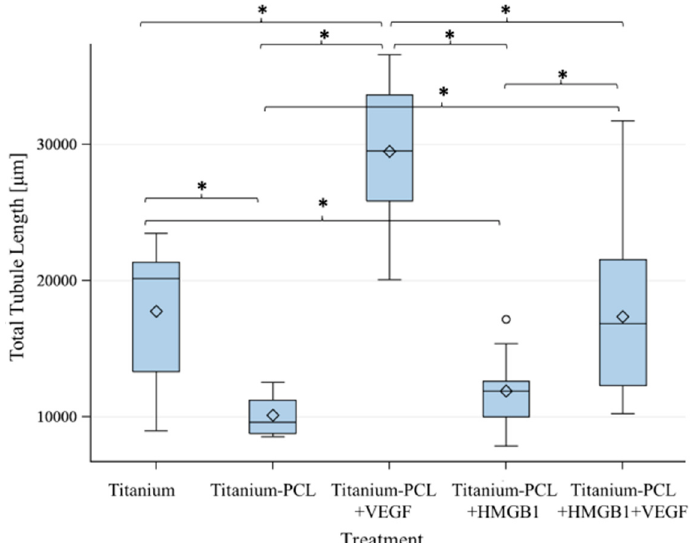
Figure 6. Total Tubule Length built by investigated implants. VEGF-functionalized titanium-PCL implants showed significantly the best results for the characteristic Total Tubule Length. VEGF + HMGB1-functionalized titanium-PCL implants showed a significantly higher Total Tubule Length than titanium-PCL implants and HMGB1-functionalized titanium-PCL implants, but comparable results to pure titanium implants. Pure titanium implants were significantly better than titanium-PCL implants and HMGB1-functionalized titanium-PCL implants. F -test from the analyses of variance followed by pairwise multiple means comparisons with the Least Significant Difference test were used ( p ≤ 0.05).